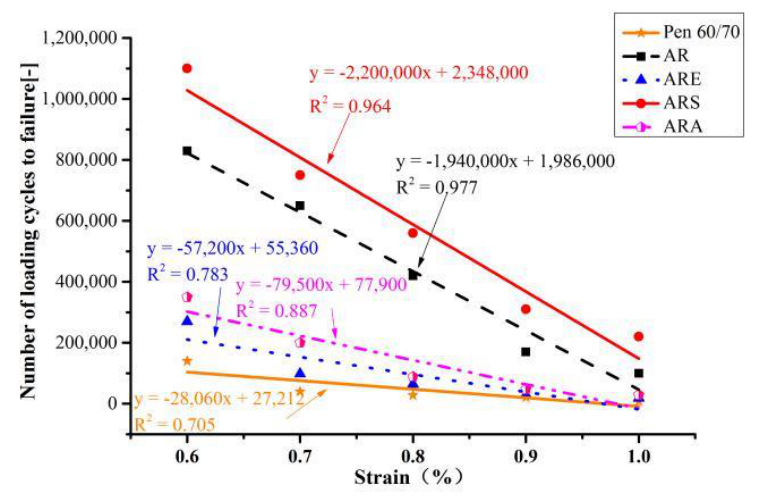
Figure 5. Shear fatigue test result for asphalt mortars.